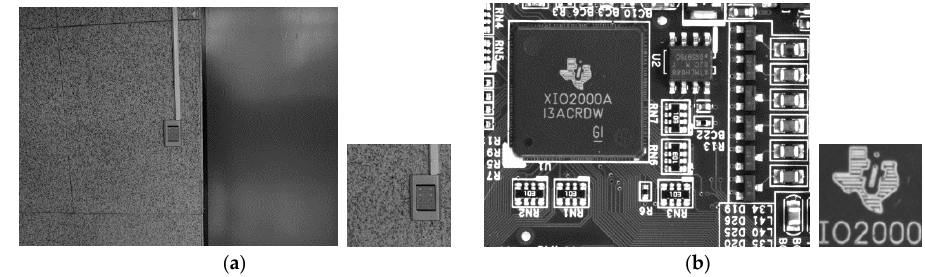
Figure 15. Test images. Sizes of all test images are 800 × 600, and the corresponding template images are ( a ) 150 × 150; ( b ) 120 × 120. Table 4. Matching errors with different weighting coefficients.